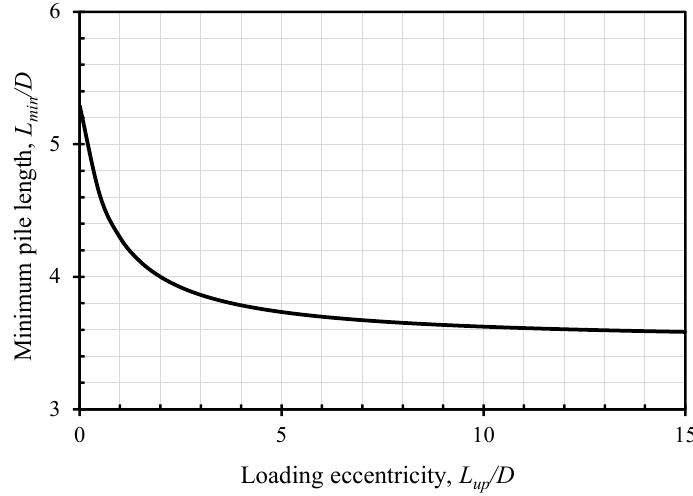
Figure 5. Variation of minimum pile length with loading eccentricity .